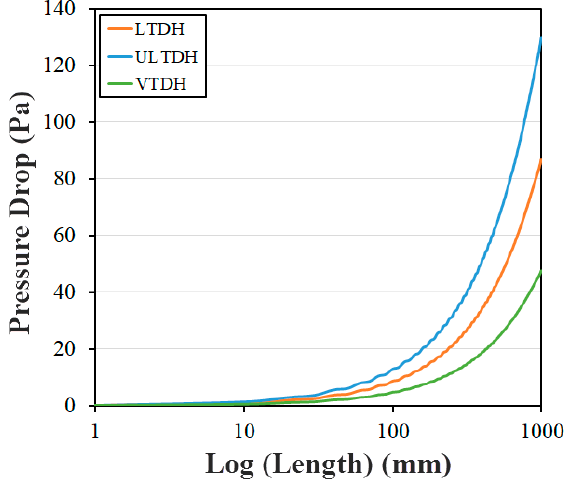
Figure 11. The level of pressure drop through the supply lines in each case.